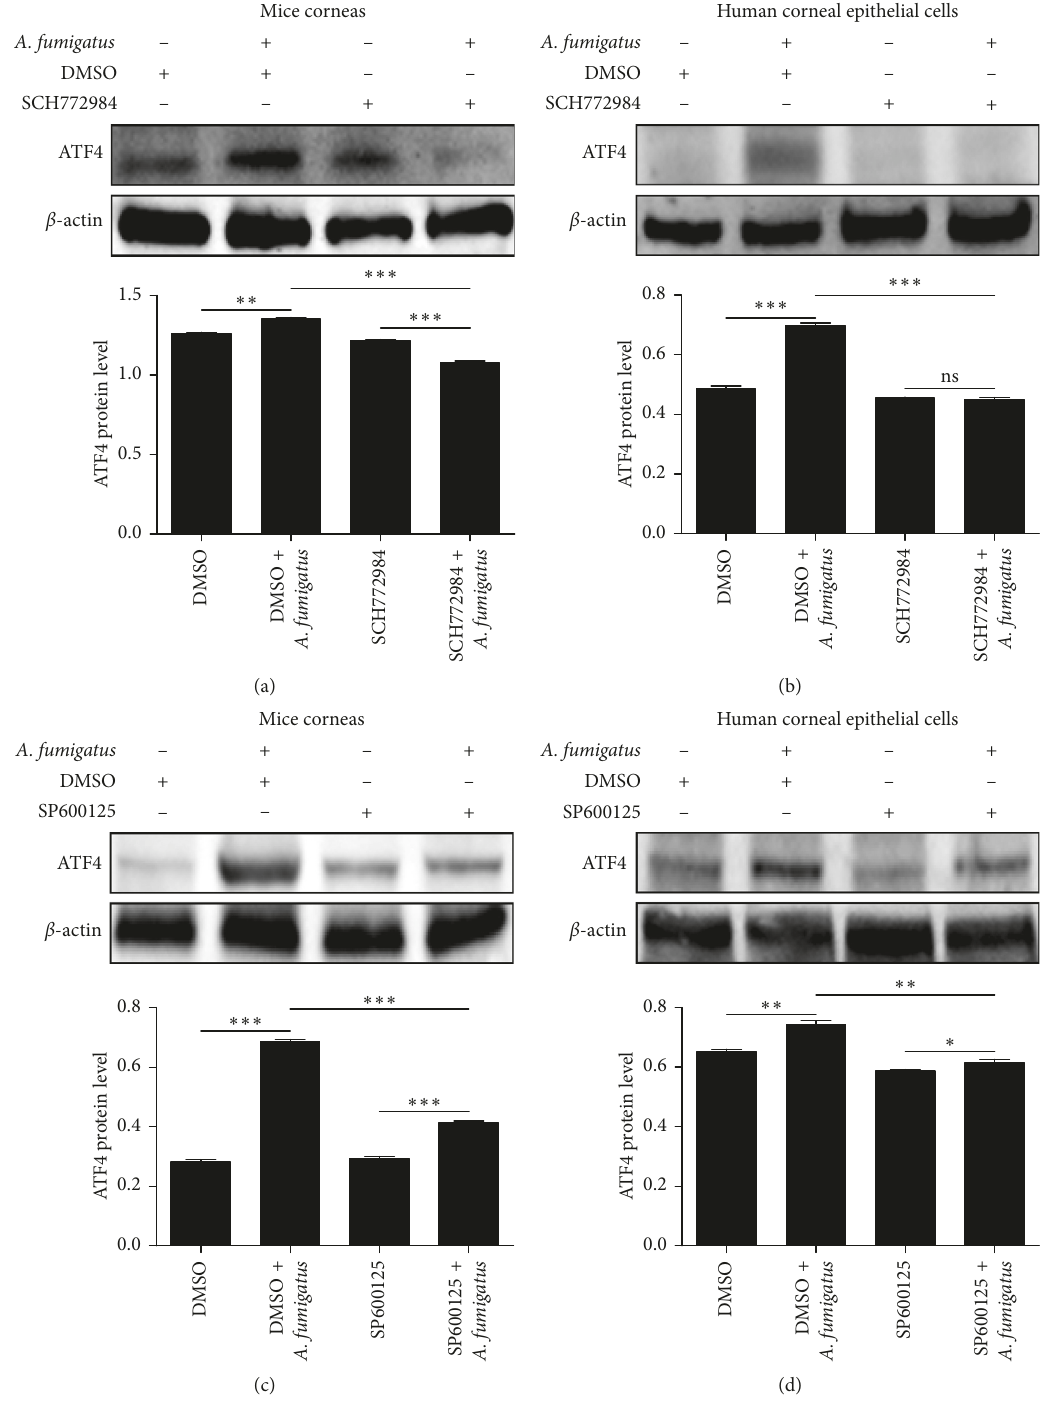
Figure 5: ERK1/2 and JNK contributed to expression of ATF4 in response to A. fumigatus. With pretreatment of an ERK1/2 inhibitor, ATF4 protein levels in infected mouse corneas (a) 1 day after infection and HCECs (b) 16 hours after A. fumigatus infection were significantly lower. ATF4 protein levels in infected mouse corneas (c) and HCECs (d) are significantly lower with pretreatment by JNK inhibitors. The mean values and standard deviations of two independent experiments are shown; ∗ P < 0 . 05, ∗∗ P < 0 . 01, ∗∗∗ P < 0 . TGF- β is a Treg-specific cytokine [33, 34], and IL-1 β is a induced by LPS in a JNK-dependent manner, which could be Th1 proinflammatory cytokine [35, 36] previously dem- inhibited by apomorphine. Our results are consistent with onstrated to be correlated with ATF4 expression. For ex- reports that ATF4 expression was upregulated with LPS ample, Liu et al. [37] showed that ATF4 and other ER stimulation in THP-1 macrophages, but not in HCECs.